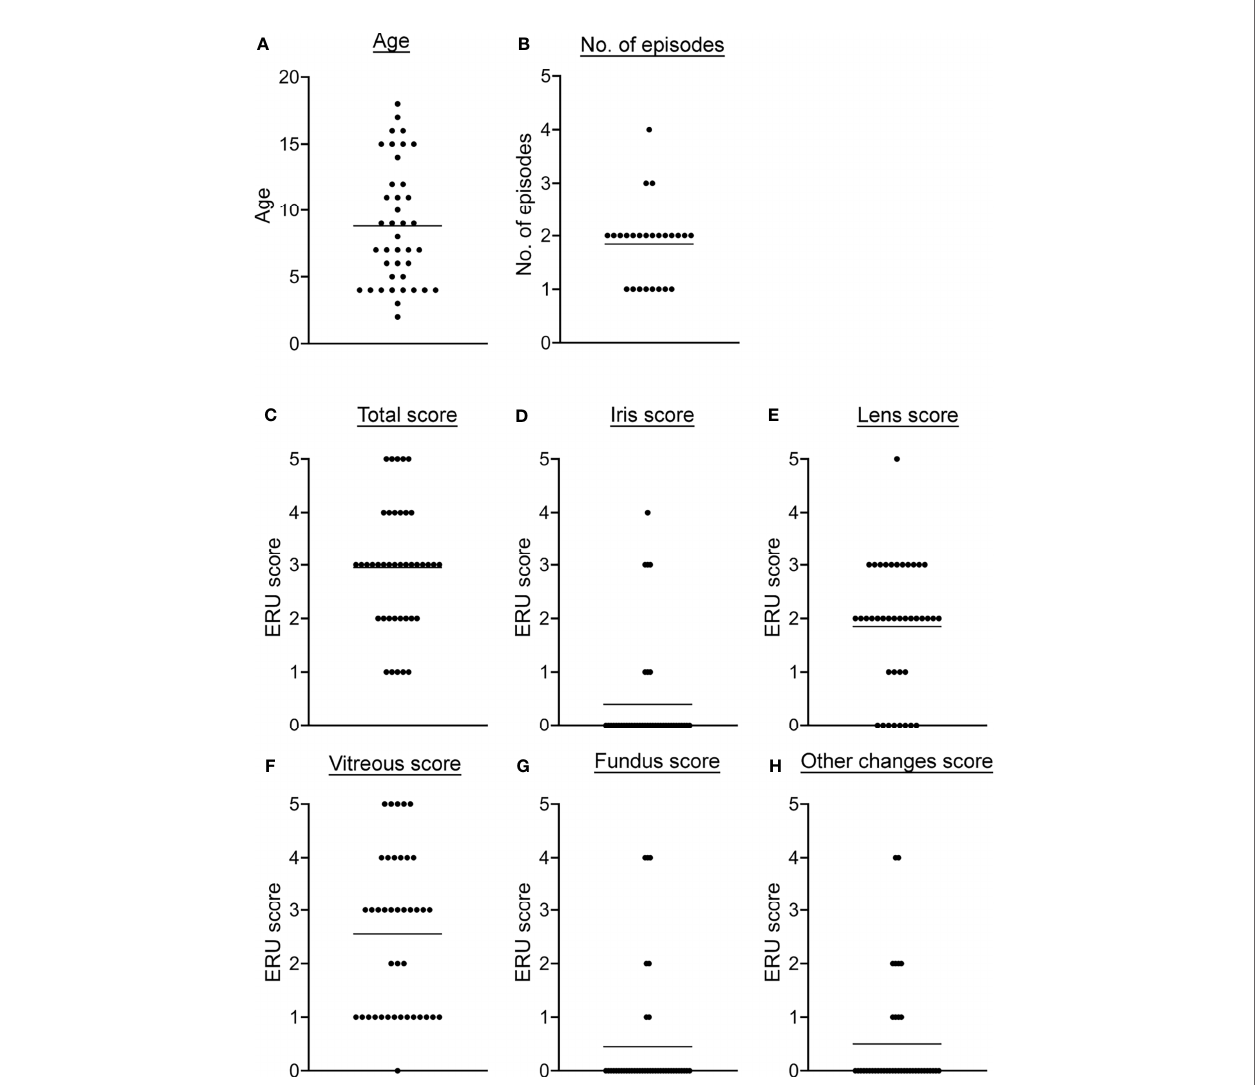
FIGURE 2 | Descriptive data and disease severity classi fi cation of ERU patients. (A) The age distribution at the examination before the vitrectomy is shown. (B) The number of previous ERU episodes of the 25 horses with obtainable data is shown. In (C – H) , the total as well as the ERU sub-scores of the different eye structures are given. Individual data points are given along with the mean value for each